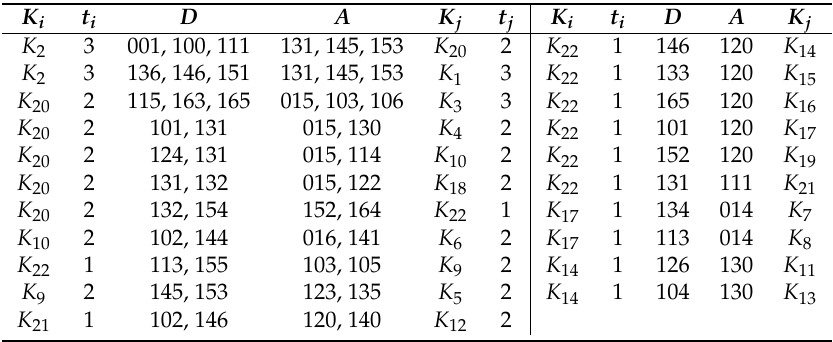
Table 4. Transition K i → K j = ( K i \ D ) ∪ A , together with the values t i = t ( K i ) and t j = t ( K j ) . K i t i D A K j t